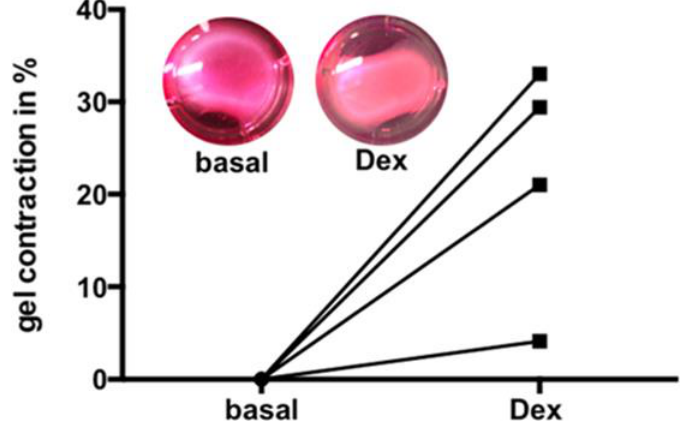
Figure 6. Dex increases contractility in HTPCs. Gel contraction assay indicates the contraction of HTPCs induced by treatment with 1 µM Dex. Decreased gel sizes after stimulation is shown as a percentage of changes of matrix after normalization to solvent control group. Cells from n = 4 patients were used. Representative examples are depicted.